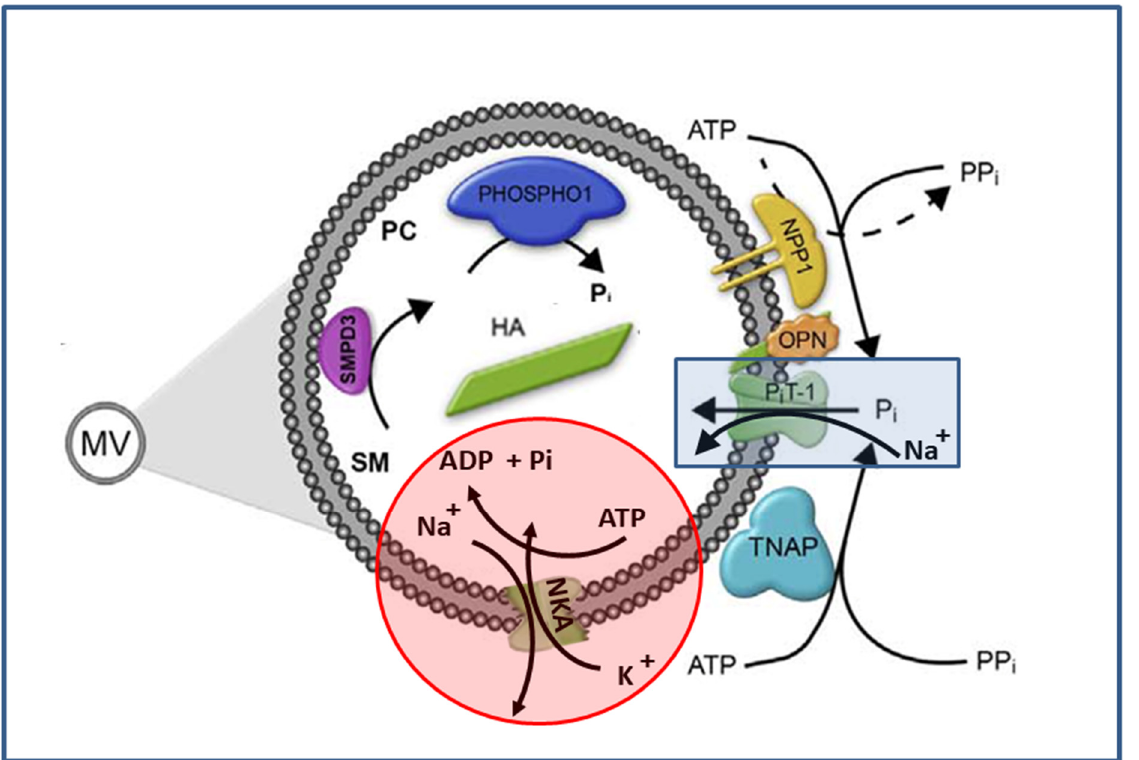
Figure 1. P i homeostasis during MV-mediated mineralization, adapted from Reference [10]. MVs provide an environment that allows the initial nucleation of apatitic mineral inside the vesicles as well as to provide nucleation sites that can help propagate the apatitic crystals onto the extracellular matrix through interaction with the collagen fibers. Orphan phosphatase 1 (PHOSPHO1) produces P i from the hydrolysis of phosphocholine (PC), which itself is derived from sphingomyelin (SM) by the action of sphingomyelin phosphodiesterase 3 (SMPD3) located in the inner surface of the MV membrane. In addition, phosphate transporter 1 (P i T-1, in blue box) and possibly other unidentified transporter(s) help supply P i ions generated perivesicularly to help nucleation of apatite (HA) inside the MVs. TNAP and NPP1 both control the extracellular PP i /P i ratio. An Na + gradient could be generated by NKA (red circle) after ATP hydrolysis inside MVs, helping increase the P i pool generated by PHOSPHO1.